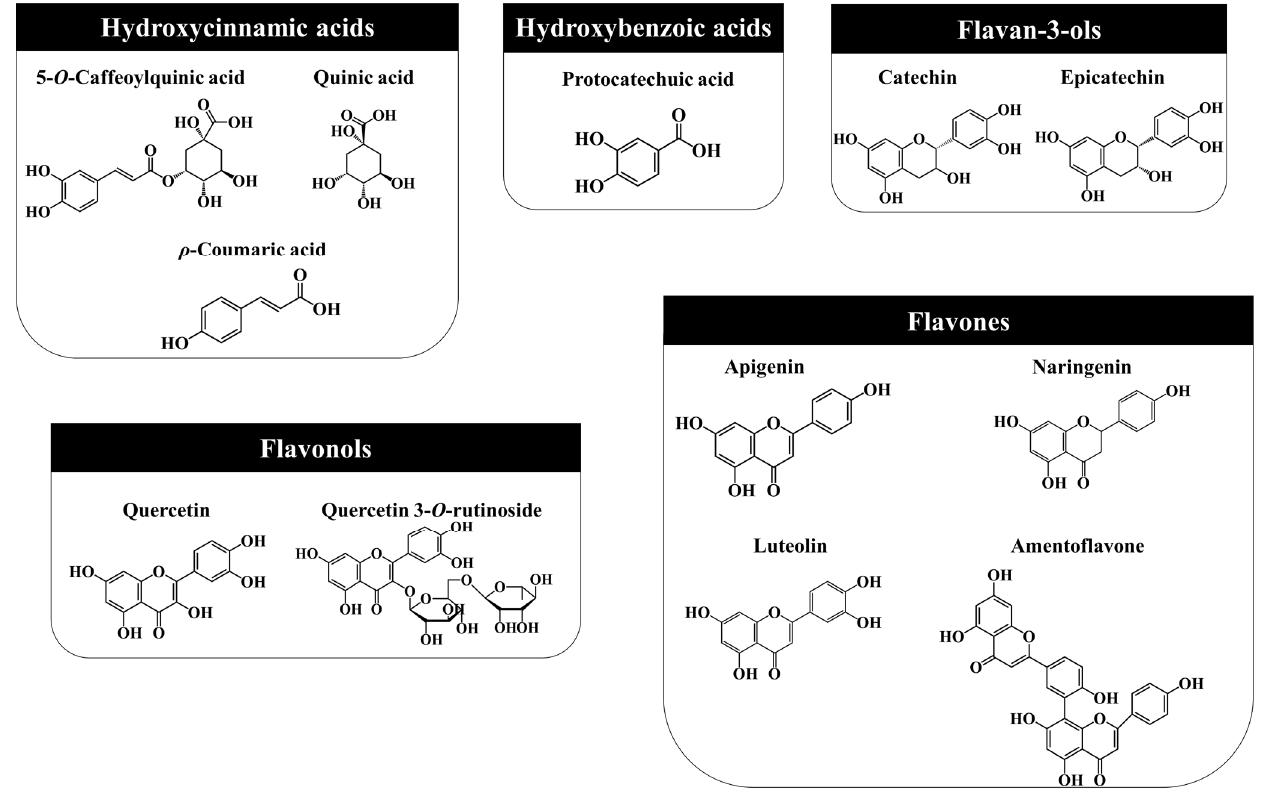
Figure 3. Main phenolic compounds found in Juniperus communis L. vegetal parts. Table 1. Total phenolic, flavonoid, anthocyanin, and tannin content of different Juniperus communis L. plant parts extracts.